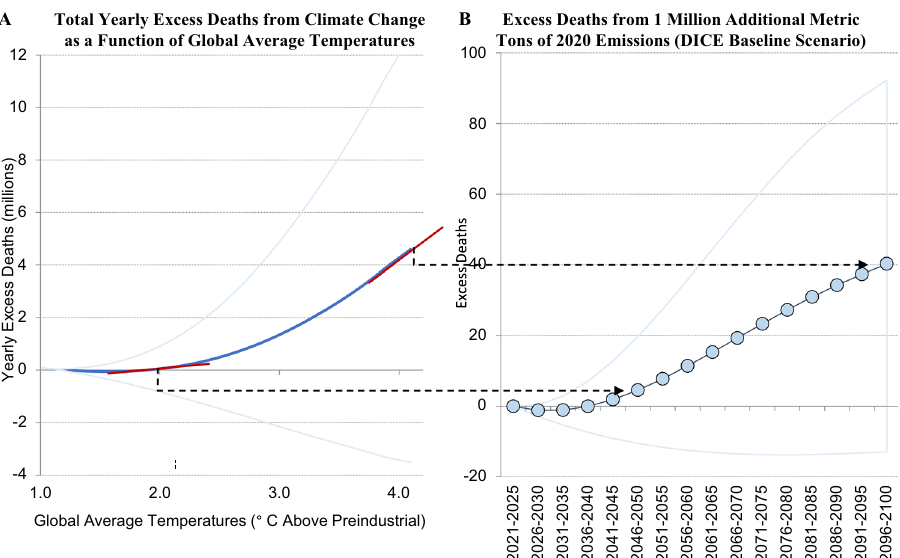
Fig. 4 The mortality cost of carbon is driven by the convexity of the mortality response. In both graphs, the high and low lines represent uncertainty with high (>90th percentile) and low (<10th percentile) estimates. A Below 2 °C, projected yearly excess deaths from climate change are relatively constant at around 100,000 per year in the central estimate. Above 2 °C, projected yearly excess deaths from climate change increase at an increasing rate in global average temperatures, rising to over four million excess deaths at 4 °C. This implies that the number of excess deaths from a marginal increase in temperatures (the fi rst derivative — represented by the red tangent lines on the graph at 2 and 4 °C) is initially relatively modest but increases substantially with increasing temperatures. B Because a signi fi cant portion of carbon dioxide emissions remain in the atmosphere for centuries after they are emitted, adding one million metric tons of carbon-dioxide-equivalent emissions in 2020 marginally increases global average temperatures through 2100. The magnitude of excess deaths from marginal 2020 emissions shown in panel B is driven by the steepness of the mortality response curve shown in panel A, which becomes progressively steeper with increasing temperatures. In the 5 years between 2046 and 2050 (when global average temperatures are 2.0 °C above preindustrial in the baseline emissions scenario), the mortality response curve is comparatively shallow, and one million marginal metric tons of carbon-dioxide-equivalent emissions in 2020 are projected to cause fi ve excess deaths in this timespan. In the 5 years between 2096 and 2100 (when global average temperatures are 4.0 °C above preindustrial in the baseline emissions scenario), the mortality response curve is comparatively steep, and these marginal 2020 emissions are projected to cause 40 excess deaths in this timespan. In total, one million additional metric tons of carbon-dioxide- equivalent emissions in 2020 are projected to cause 226 excess deaths in the 80 years between 2020 and 2100 in the baseline emissions scenario. These are concentrated at the end of the century when global average temperatures are highest and marginal changes to temperatures are most